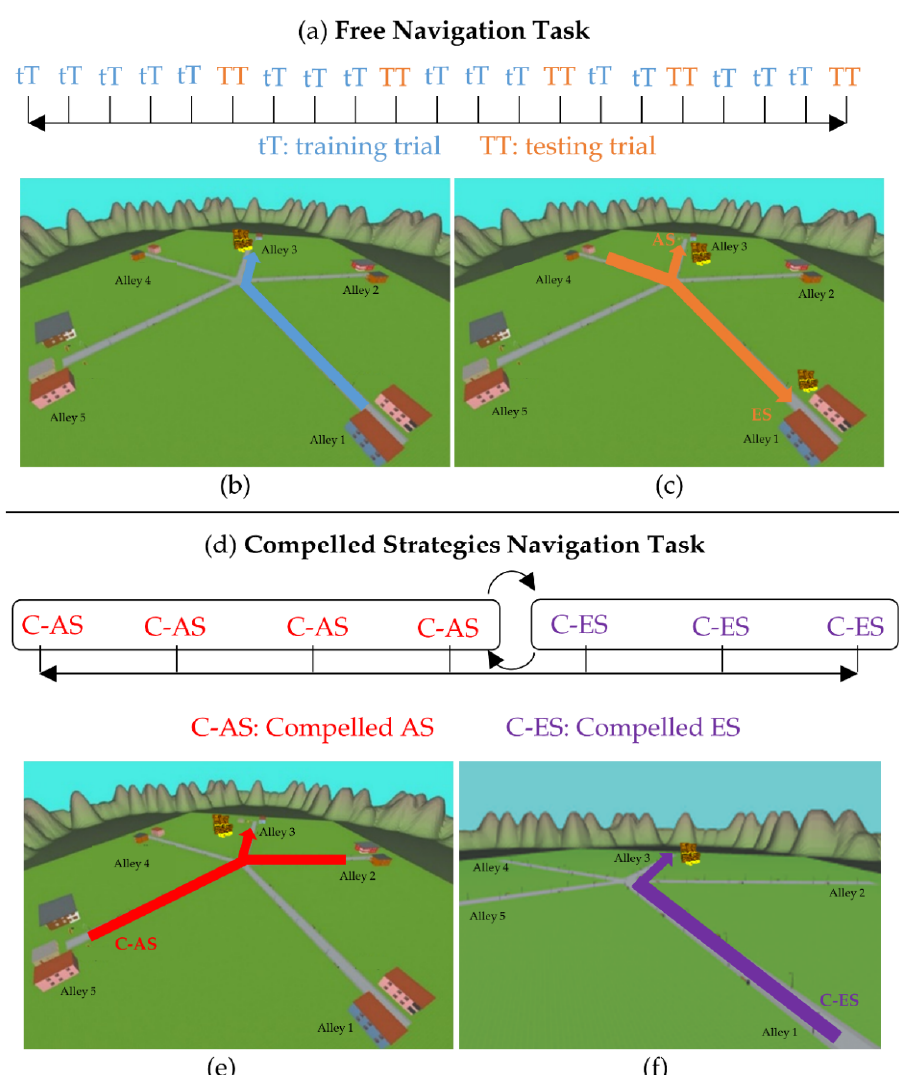
Figure 3. ( a ) Schematic representation of the Free Navigation Task in which the participant had to search for the treasure 21 times: 16 trials of training and 5 trials interposed to assess whether he/she resorted to AS or ES to solve the task. ( b ) Path to be followed during the training trials in the Free Navigation Task (blue path). ( c ) Path to be followed during the testing trials in the Free Navigation Task (orange path): the subject resort to an allocentric strategy if he/she goes to alley 3, to the egocentric if he/she goes to alley 1; ( d ) schematic representation of the Compelled Strategies Navigation Task in which the participant was asked to resort to a given strategy to get the treasure: there were four “compelled AS” trials and three “compelled ES” trials; the order of the egocentric and the allocentric versions of the task were counterbalanced among the subjects. ( e ) Two paths imposed during compelled allocentric trials (red paths). ( f ) The bare maze used in the Compelled Strategies Navigation Task with the path imposed during the compelled ES (violet path).